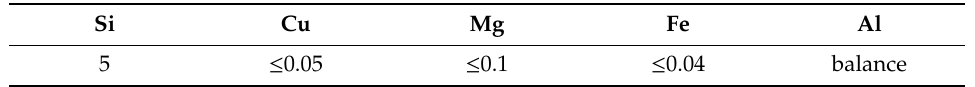
Table 2. Chemical composition of ER4043